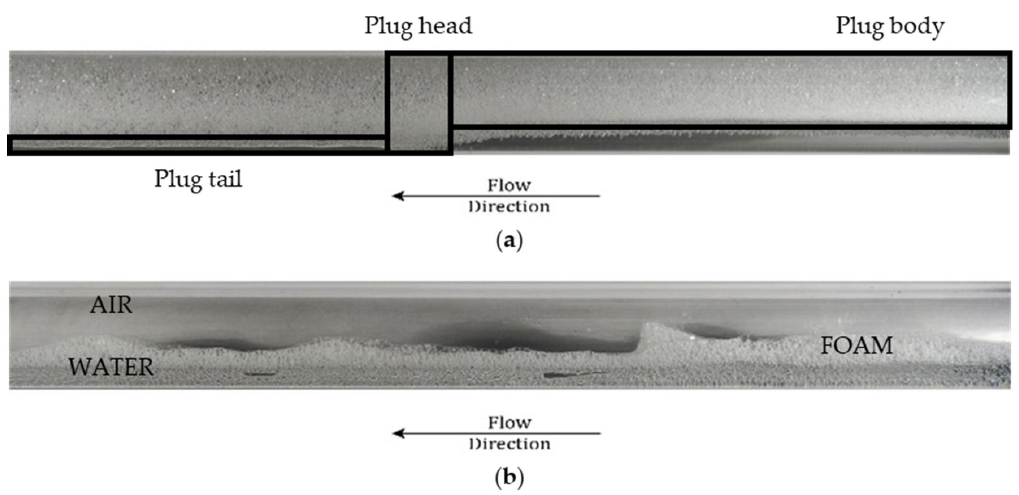
Figure 2. Examples of two foamy flow conditions ( a ) plug flow at J L = 0.03 m/s and J G = 0.41 m/s and ( b ) stratified flow at J L = 0.03 m/s and J G = 2.31 m/s (D = 60 mm).